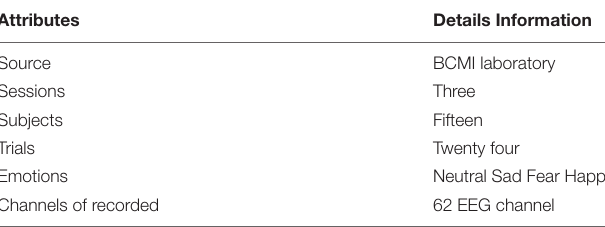
TABLE 2 | Information about SEED-IV dataset.